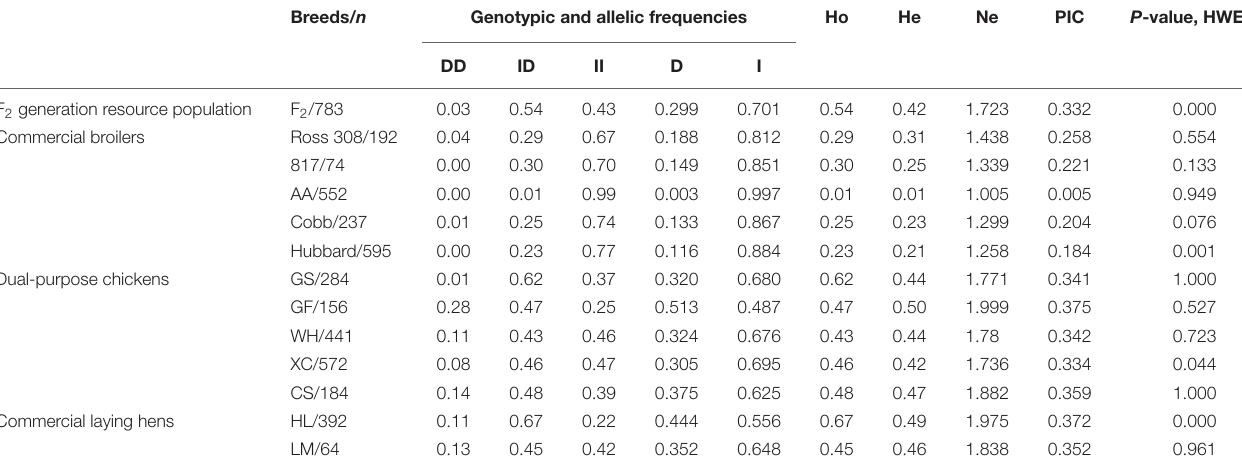
TABLE 2 | Genetic parameters of 104-bp locus within ADPRHL1 gene in F 2 and other 12 chicken breeds. Breeds/ n Genotypic and allelic frequencies Ho He Ne PIC P -value, HWE